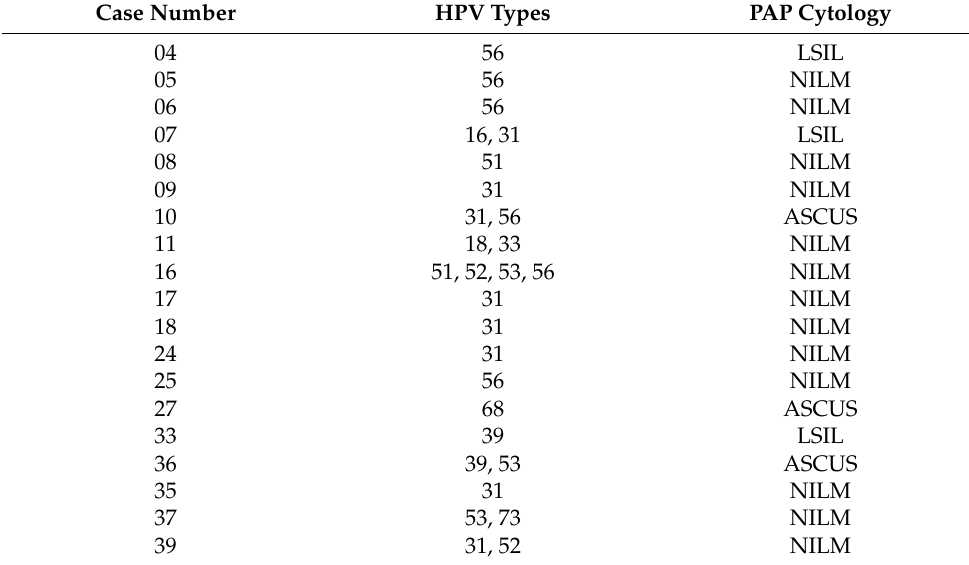
Figure 3. Cytology findings in different HR-HPV types. Table 2. Association between HPV types with cytological results in HPV-positive women. Case